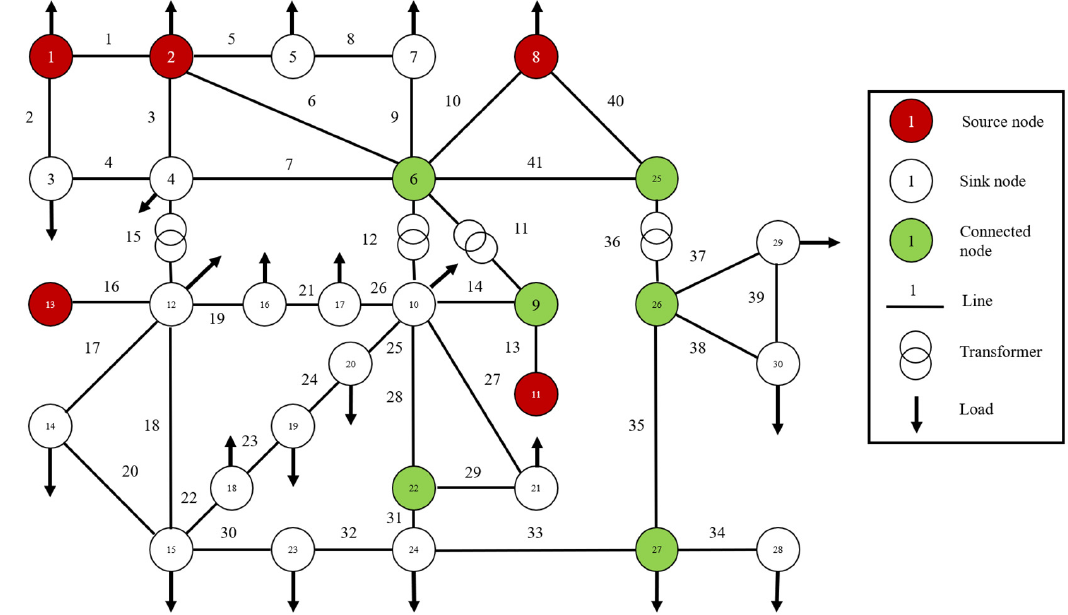
Figure 11. IEEE-30 bus system topology model diagram. Table 1. IEEE-30 system node type.